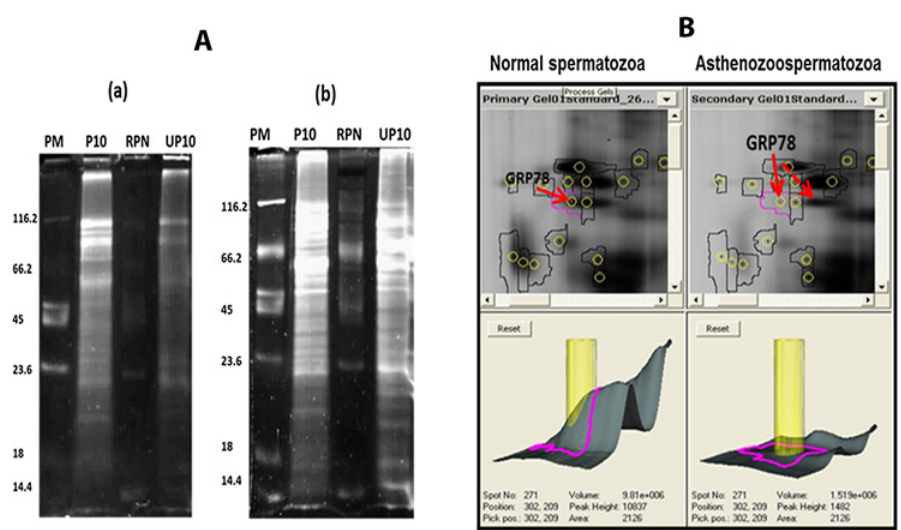
Fig 1. Differential expression of phosphorylated GRP78 in asthenozoosperm. A) Phosphoprotein enrichment. 10 μ g of phosphorylated (P10) and unphosphorylated (UP10) fractions of sperm lysates were electrophoresed on 1D SDS-PAGE and stained with Pro-Q Diamond Phosphoprotein gel stain which stains only phosphoproteins ( a ) and subsequently with SYPRO 1 Ruby which stains all proteins ( b ). This phosphoprotein enrichment was done for both normal and asthenozoospermic samples. PM: Peppermint phospho marker, RPN756: was the protein marker used (GE Healthcare Life Sciences, UK). B) A representative DIGE gel showing the profile of a few proteins in normal sperm and asthenozoosperm. The image on the left represents a snapshot of a fewphosphoproteins from normal sperm (Cy 3 labelled) and one on the right represents the same snapshot but that of asthenozoosperm (Cy 5 labelled). The arrow indicates identity of the spot as GRP78. Dotted arrow in the snapshot for asthenozoosperm points to the shifted location of phosphorylated GRP78 to the basic side suggesting less phosphorylation as compared to